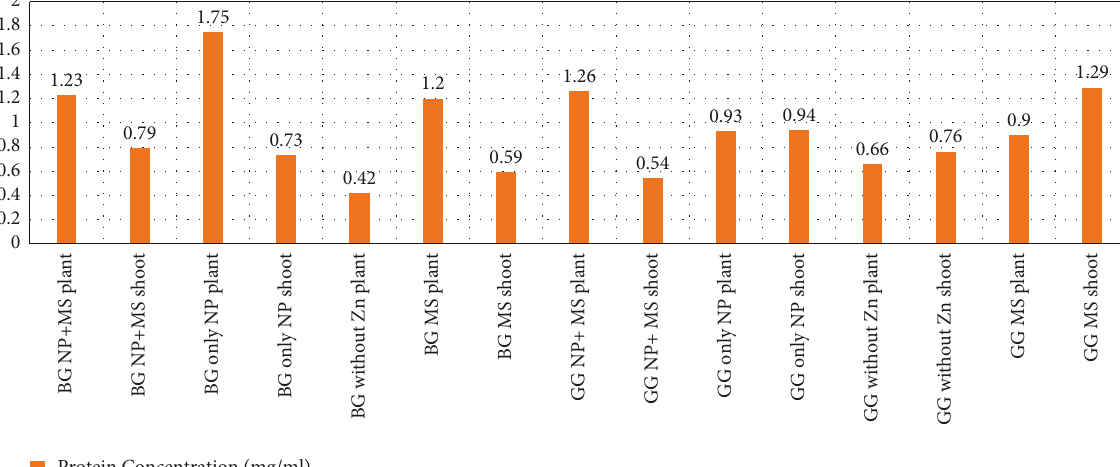
Figure 7: Protein estimation after 7 days, the 2nd set. BG: Bengal gram and GG: green gram.